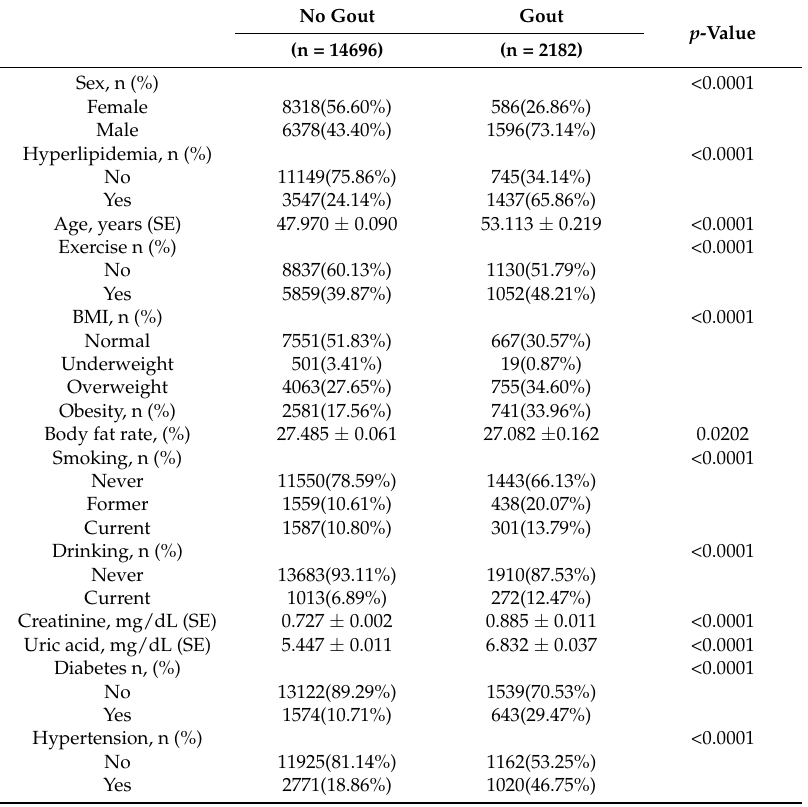
Table 1. Baseline characteristics of study participants.